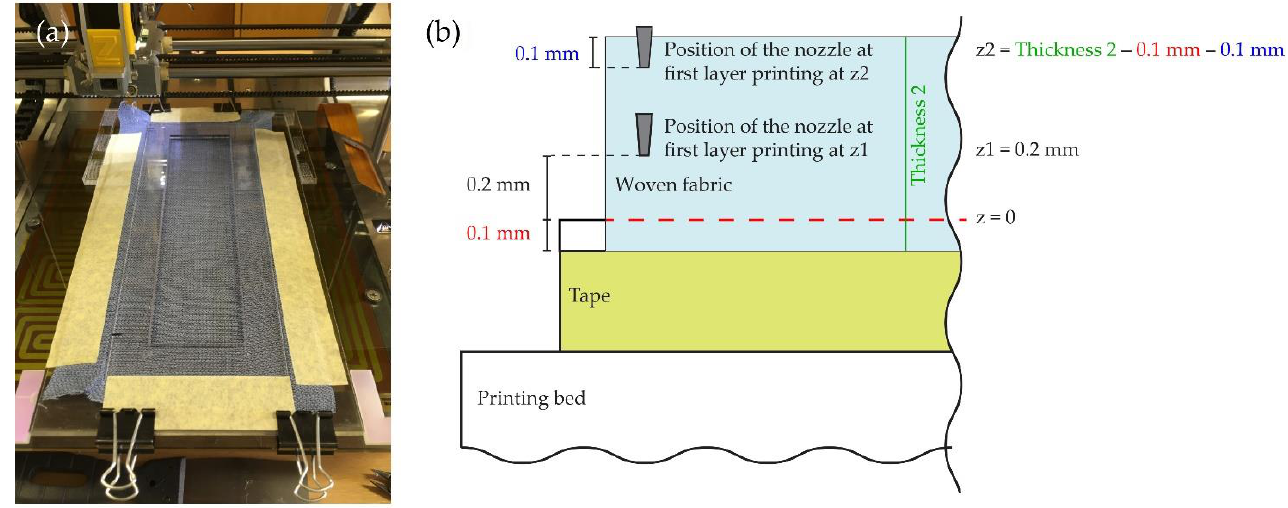
Figure 1. ( a ) Positioning of the mounting frame and installation on the printing bed; ( b ) Scheme of the z-distance calculation. the z-distance calculation.